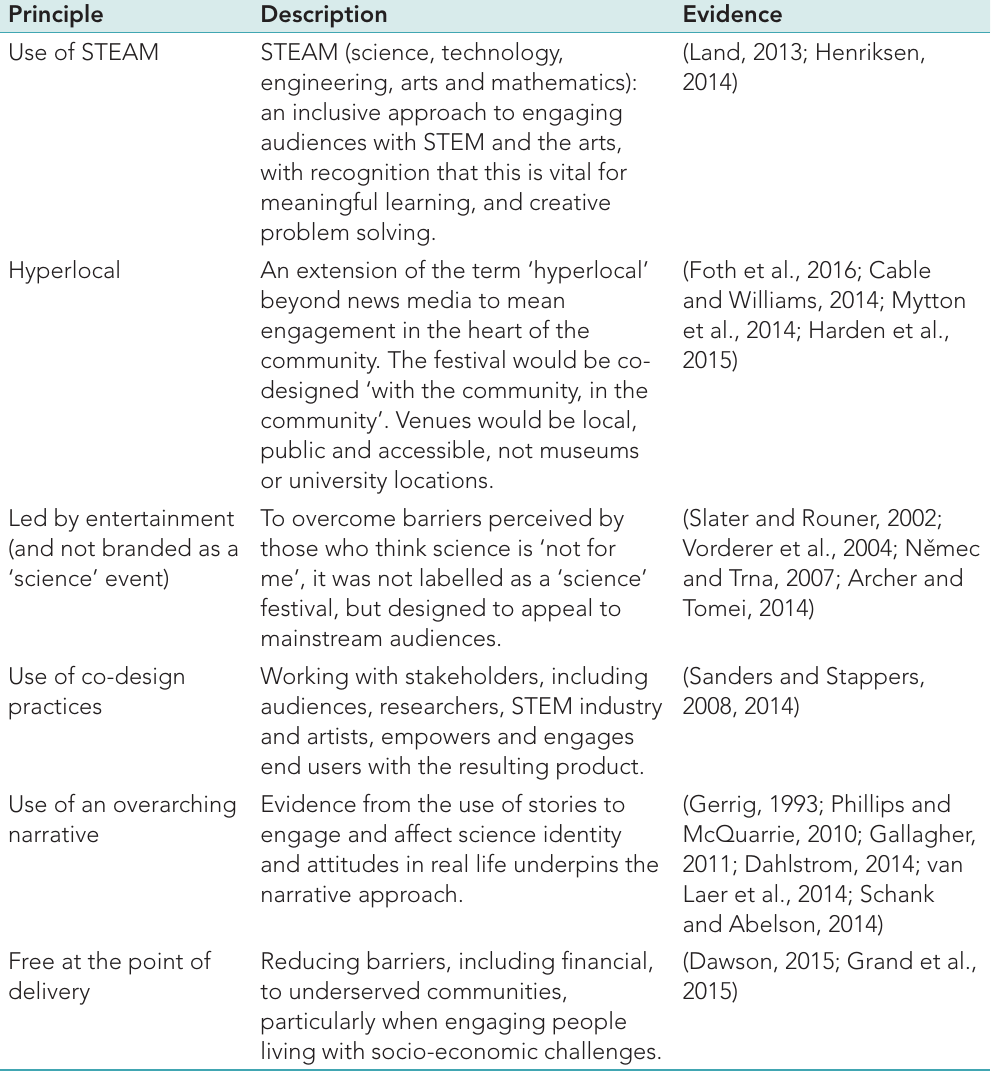
Table 1: The founding principles of sMashfestUK